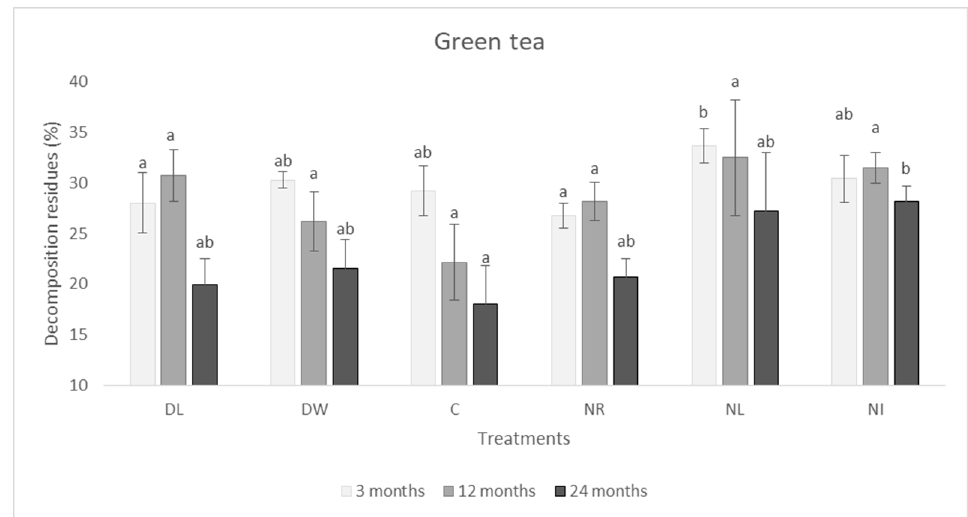
Figure 5. Effect of organic matter manipulation experiments with different DIRT treatments on green tea degradation rate after 3, 6 and 12 months: The letters represent significant differences between treatments during the given period ( n = 4).